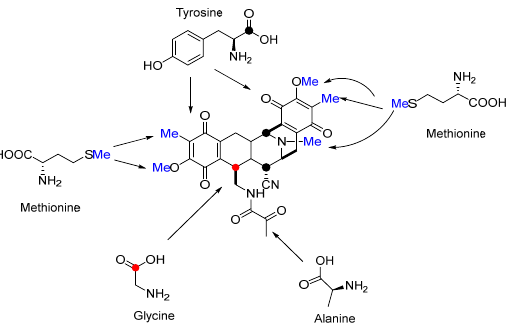
Figure 18. Origins of saframycins revealed by isotopic precursors labeling experiments.